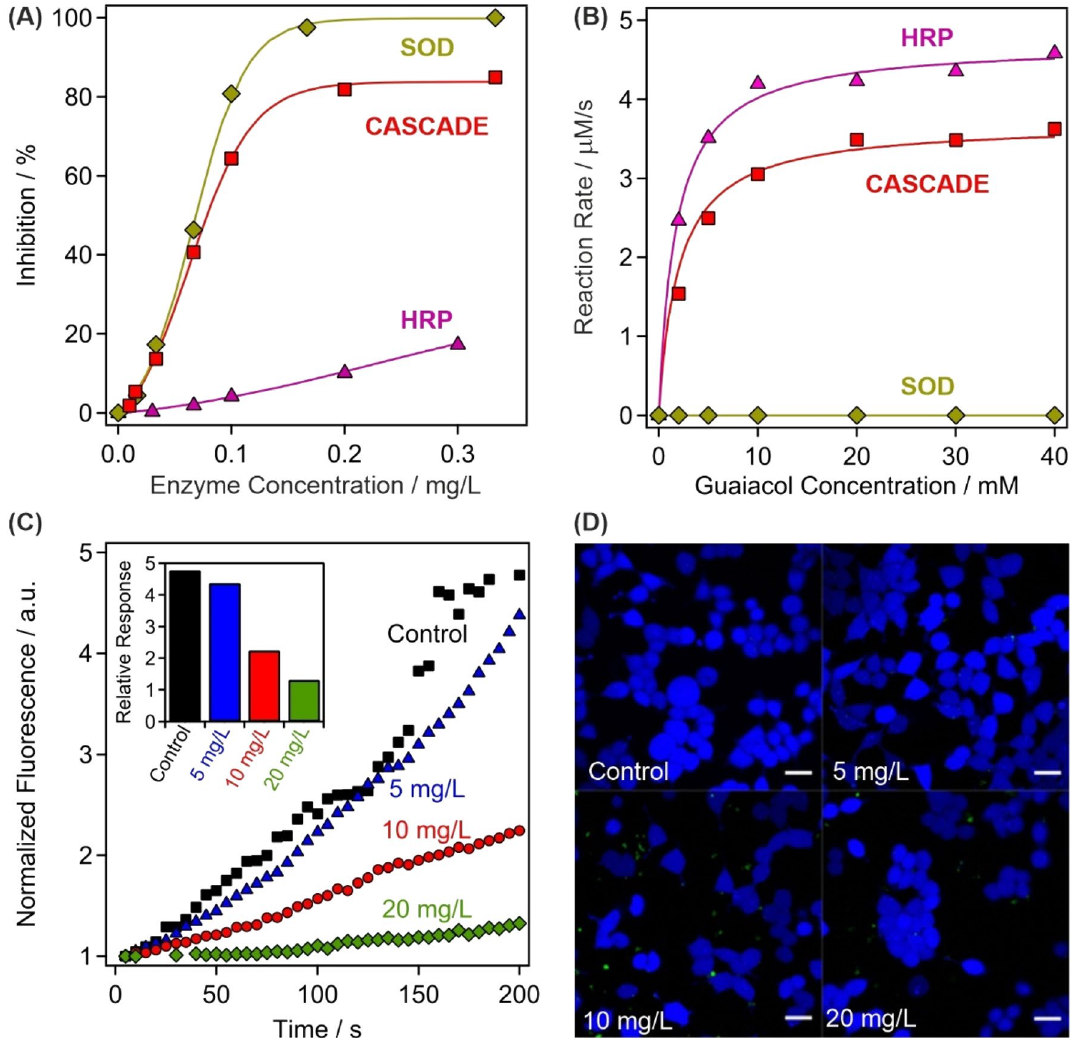
Figure 3. Assessment of the antioxidant activity of CASCADE. (A) SOD-like activity expressed by the inhibition of the NBT-superoxide radical reaction. The lines are mathematical functions used to interpolate the IC 50 values. (B) HRP-like activity measured in the guaiacol-hydrogen peroxide reaction, where CASCADE acts as a catalyst. The solid lines represent the fits using the Michaelis–Menten model. (C) The fluorescent intensity of H 2 DCFDA dye over time at different CASCADE loadings into HeLa cells. The maximal relative response of the detected fluorescent intensity is shown in the inset and in Table S1. (D) Live (blue fluorescent) HeLa cells were observed during the control experiments and at 5, 10 and 20 mg/L CASCADE doses. Scale bars represent 20 μm dimension.